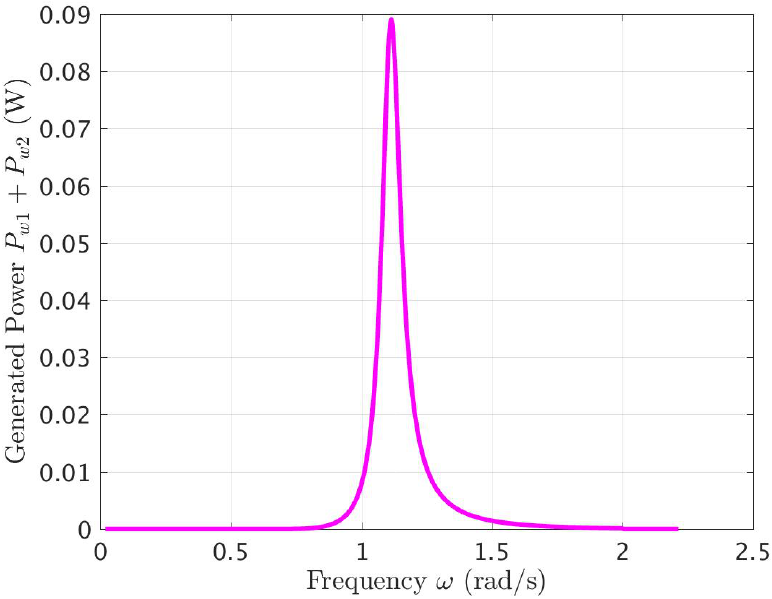
Figure 8. Combined power conversion by Galfenol strips on each beam in response to an irregular wave spectrum (Pierson-Moskowitz, H s = 1.0m, T = 5.0s.). Beams fit the deck support tightly.